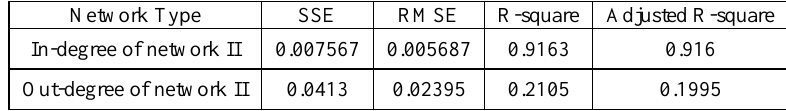
Table 2. The fitting results of degree distribution (95% confidence